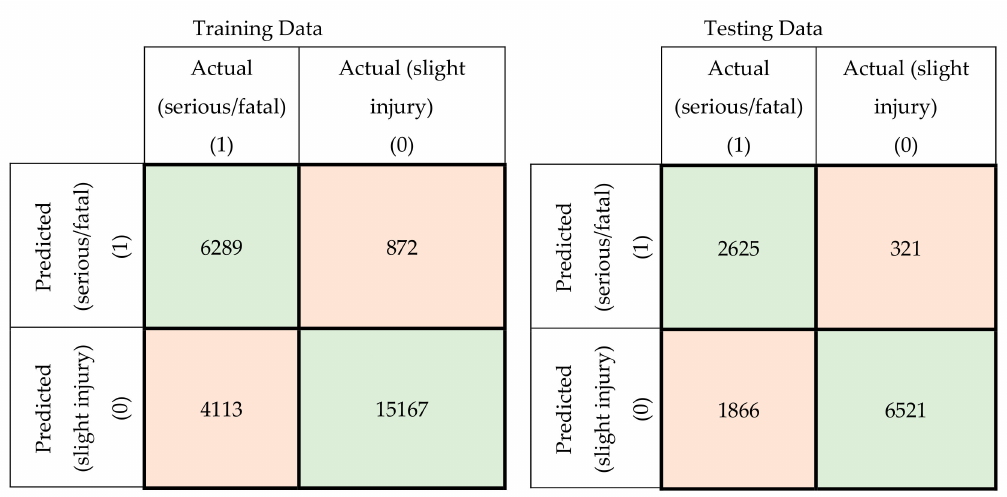
Figure 8. Confusion matrices for the SVM model using principal components (training and testing